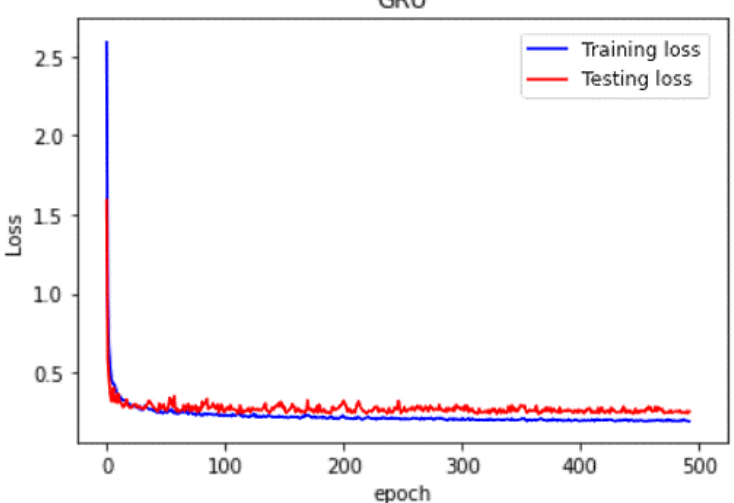
Figure 10. Loss vs epoch plot of Scenario 15 of the GRU model.